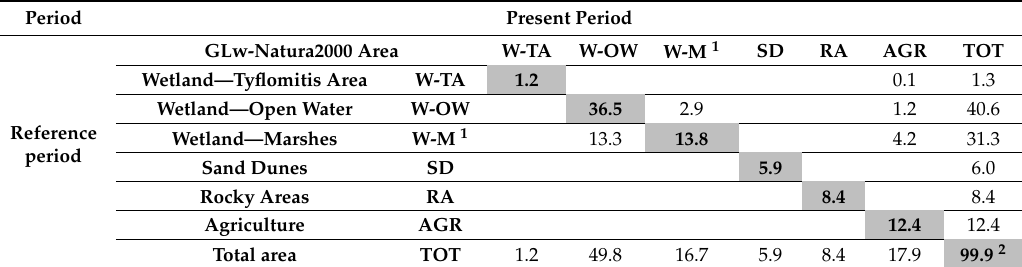
Table 1. Area coverage (% of total studied area) of different classes in reference (prior to 1960) and present (2010) periods. The studied area includes the GLw-Natura2000 and the Tyflomitis area. The percentage coverage of each class before and after human interventions is given in the right column and last line, respectively. Areas that do not change are displayed on the diagonal of the table. Changes (gains or losses) in area coverage are displayed in the cells outside the diagonal (e.g., 13.3% of the area belonged to the W-M class in the reference period, but became part of the W-OW class in the present period). Errors attributable to uncertainties in the definition of the land use polygons amount to less than 0.5% of the total area.